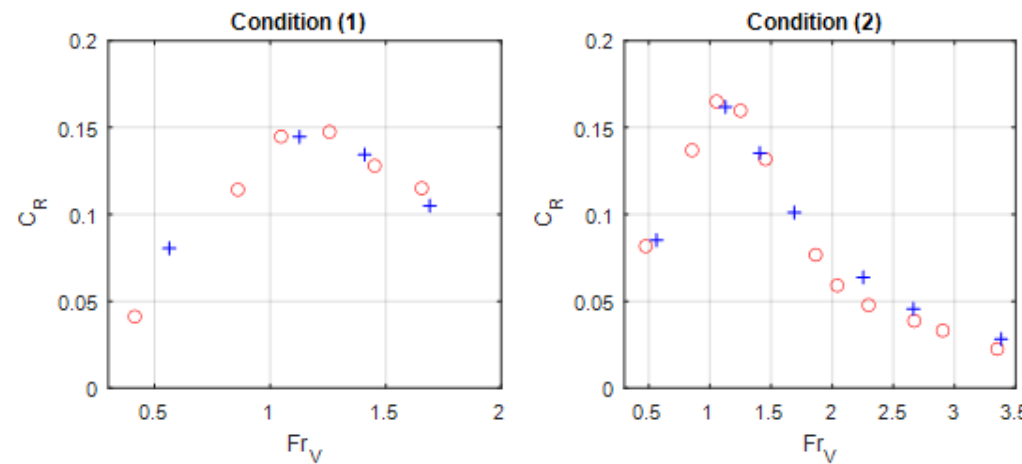
Figure 9. Experimental and numerical results for constant-deadrise hull, C B = 0.912 and two LCG conditions: ( 1 ) LCG = 45%, ( 2 ) LCG = 40%. Red circles, experimental data; blue crosses, numerical results.